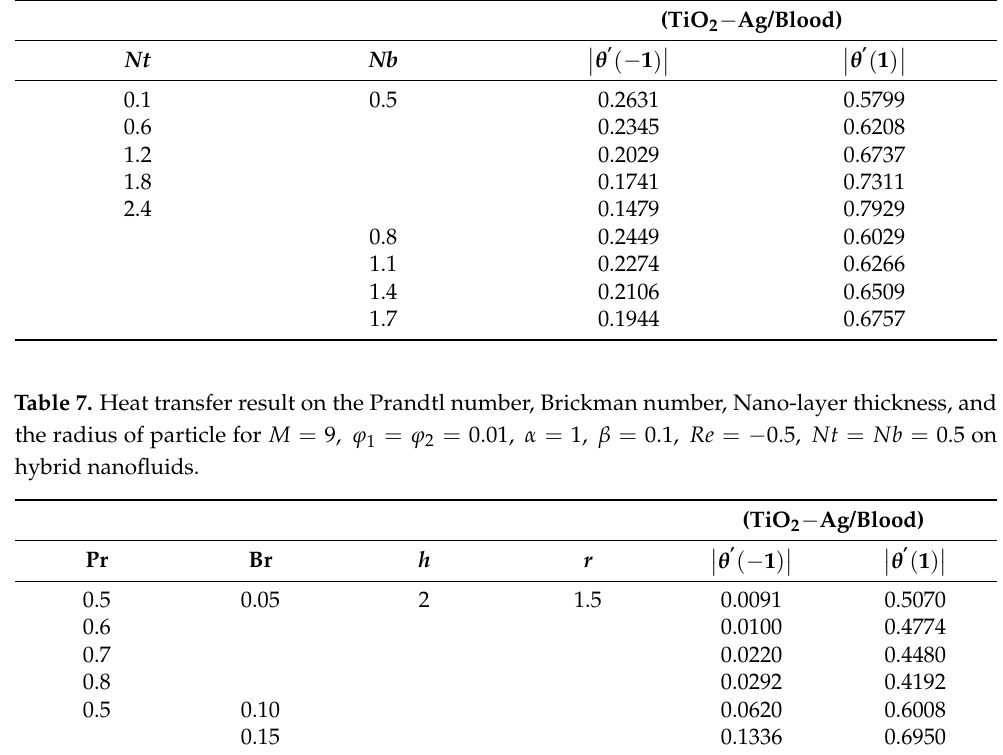
Table 6. Heat transfer result on thermophoresis motion and Brownian motion for Pr = 0.1, M = 9,